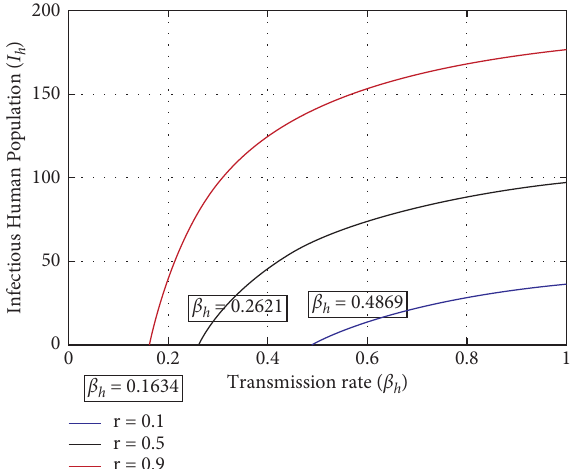
Figure 12: Bifurcation diagram with different values of r when 0 < k < 1.